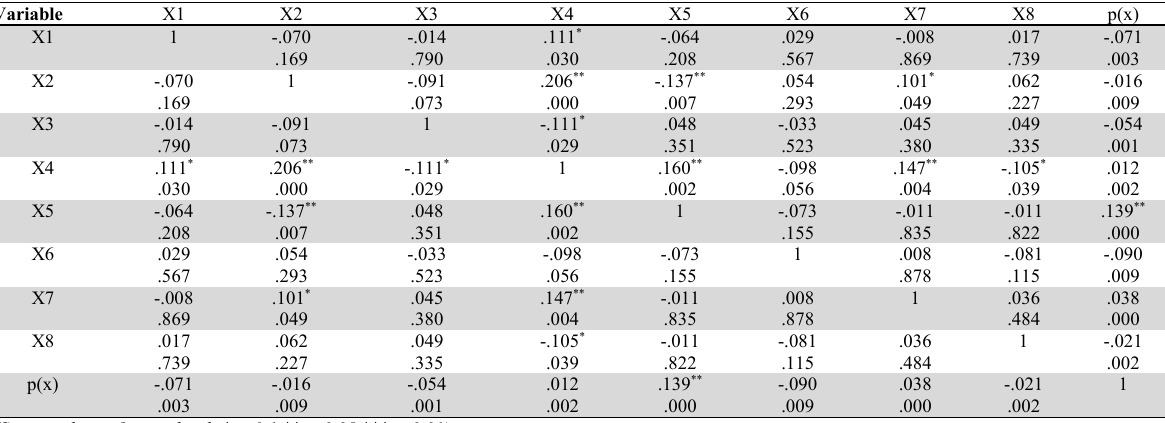
The correlative matrix between variables Variable